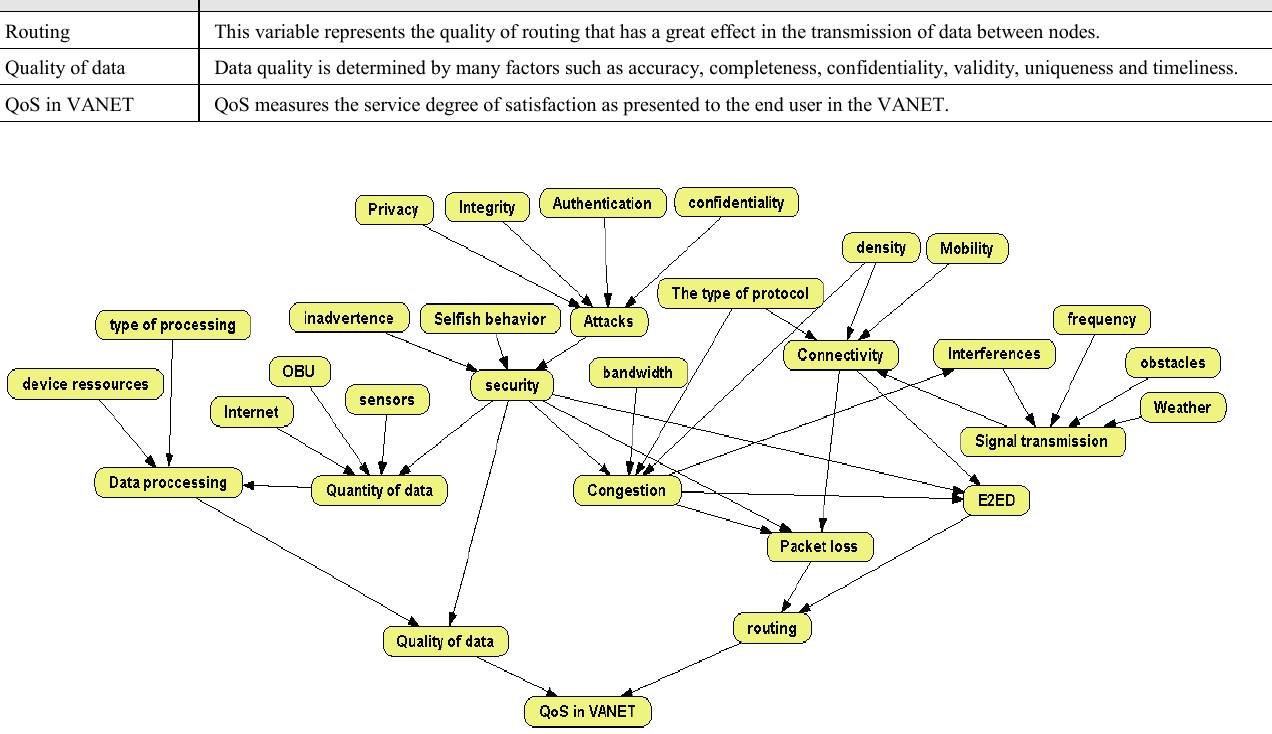
Fig. 2. BN modelling the analyses of risk of QoS in